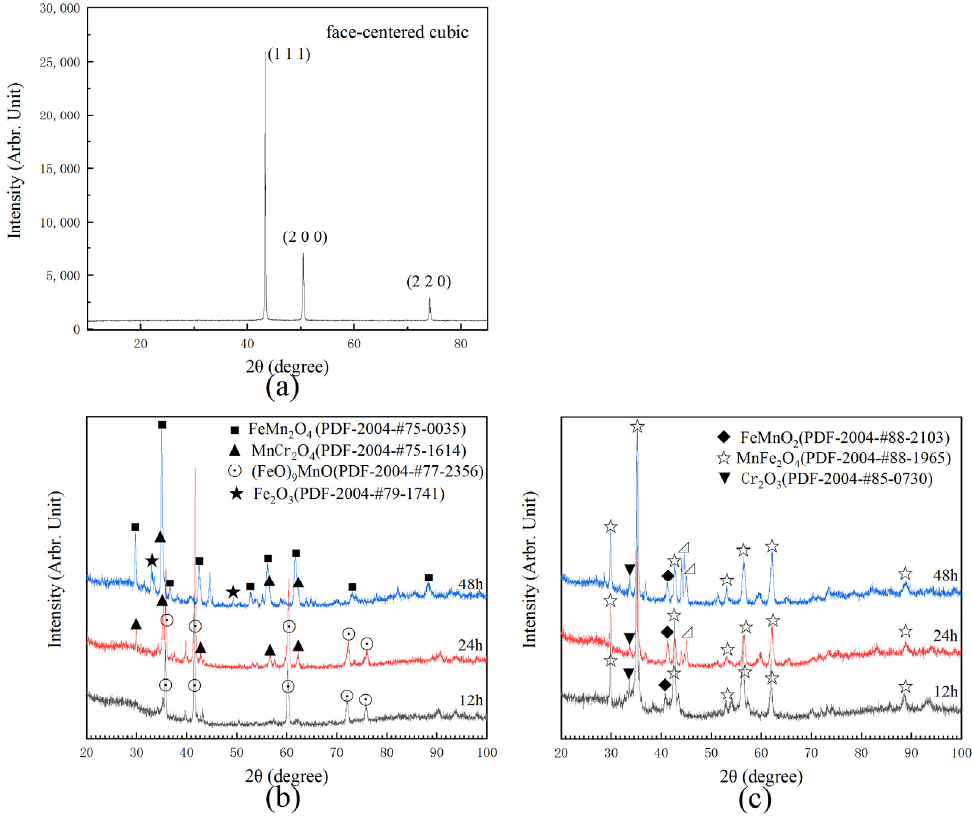
Figure 3. XRD results of HEA: ( a ) XRD spectra of the initial alloy; ( b , c ) XRD spectra after isothermal oxidation tests at 700 °C and 900 °C, respectively.